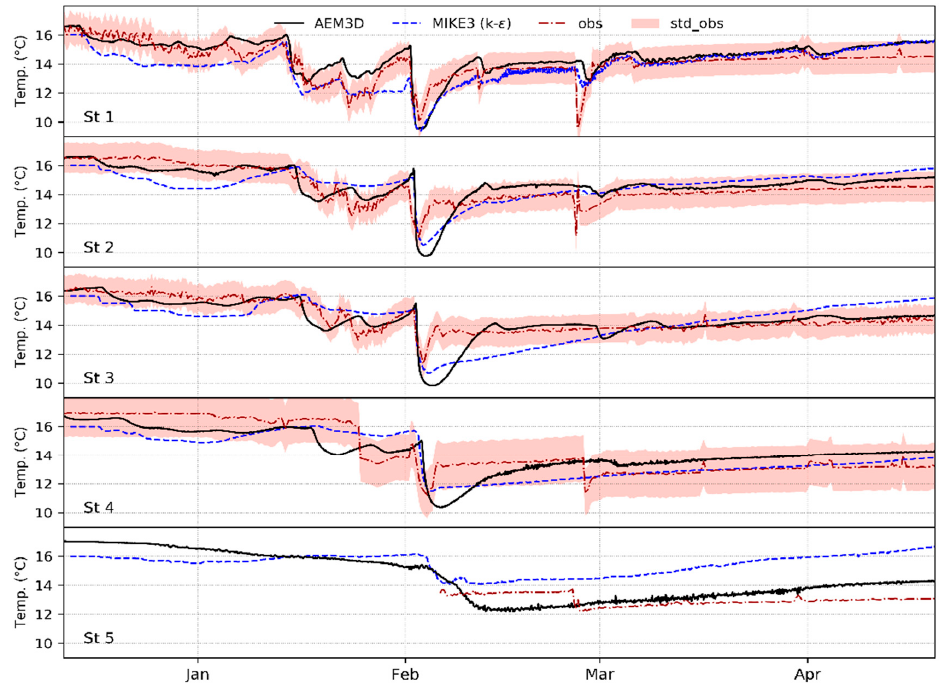
Figure 6. Observed (red dashed) and simulated water temperature using AEM3D (black) and MIKE3 with k- ε vertical discretization (blue dashed) versus measured values for the five gauging stations. All water temperatures are taken at sensor depths (2 m above bottom). Light red bands indicate the range of the ±standard deviation of the measured data. The red band at St5 is intentionally not indicated, as the observed data of St5 represent a shorter period (from February) than other stations.